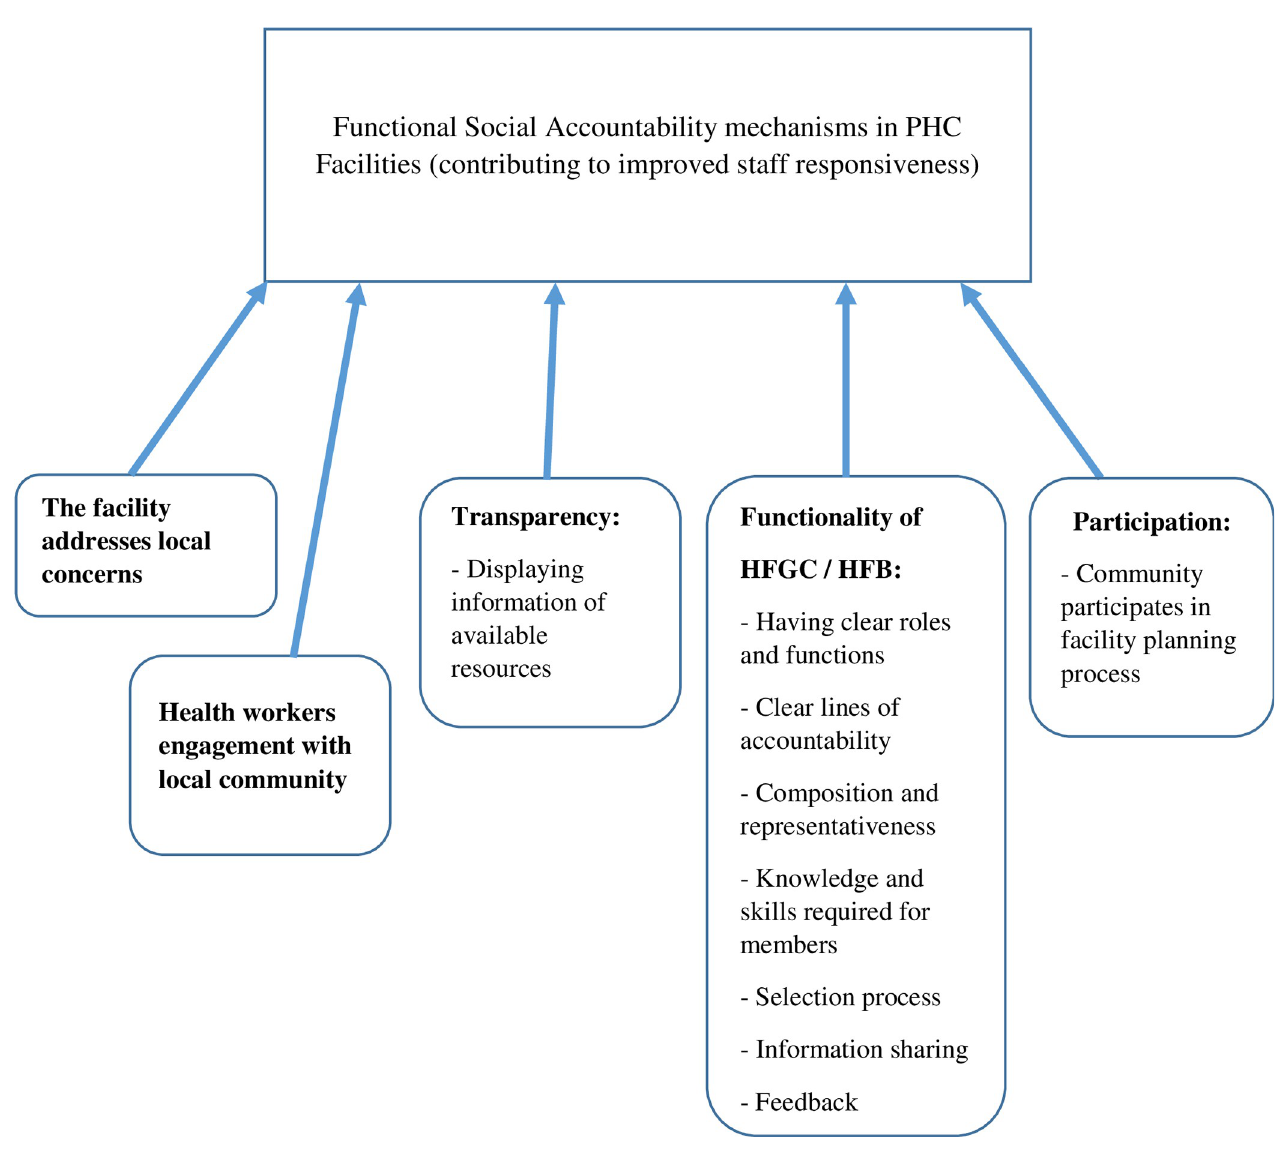
Fig 1. Conceptual framework for social accountability in PHC